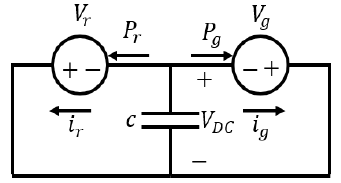
Figure 3. DC-link capacitor of DFIG.